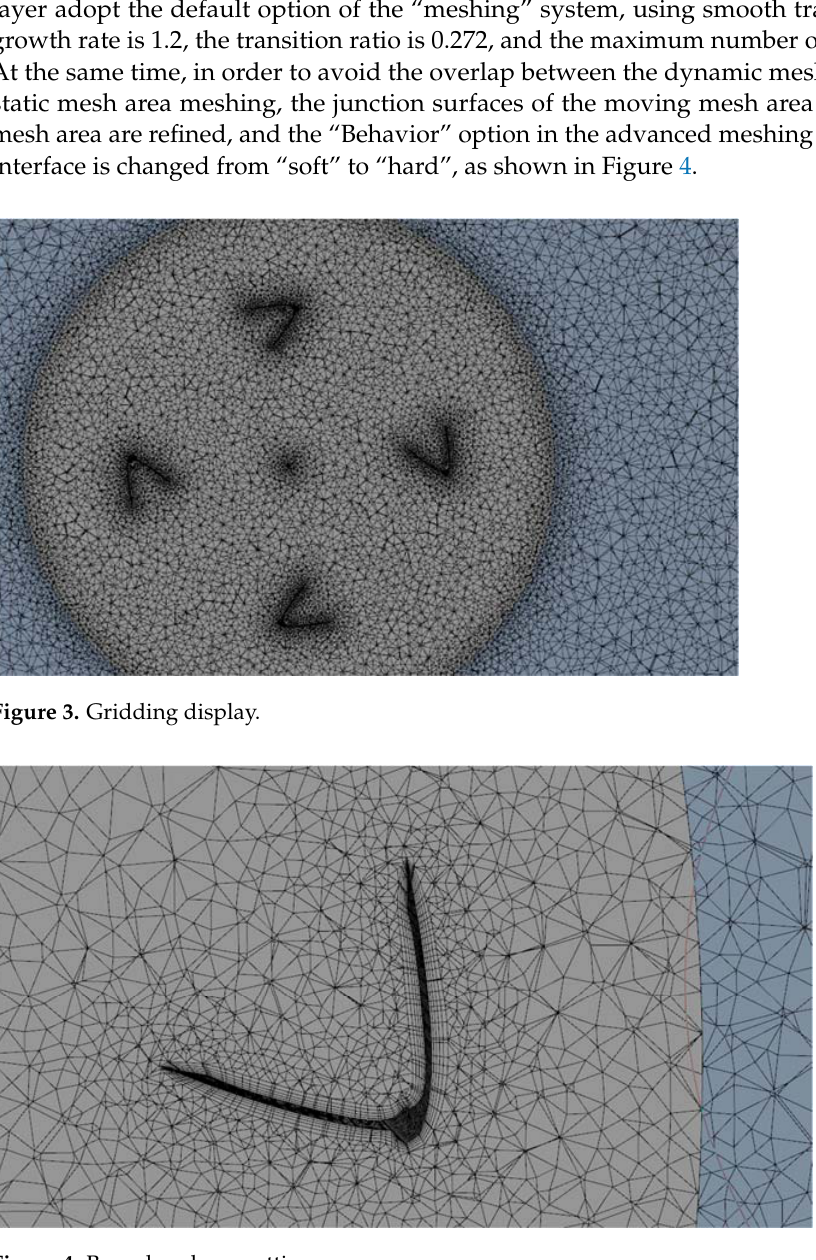
Table 2. Grid independent verification scheme.